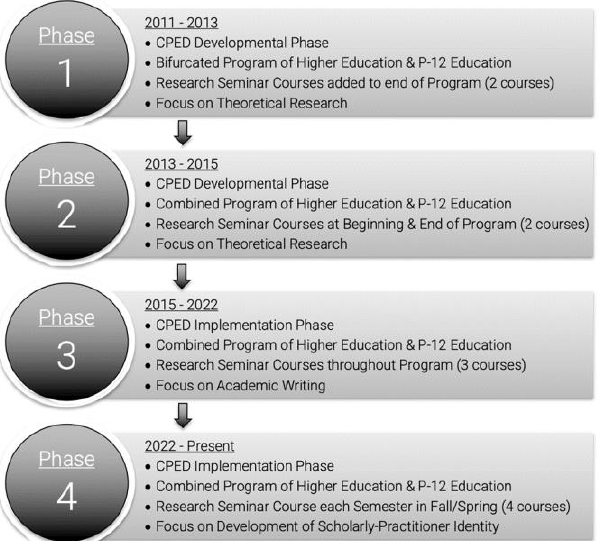
INQUIRY AS PRACTICE AS THE PATH